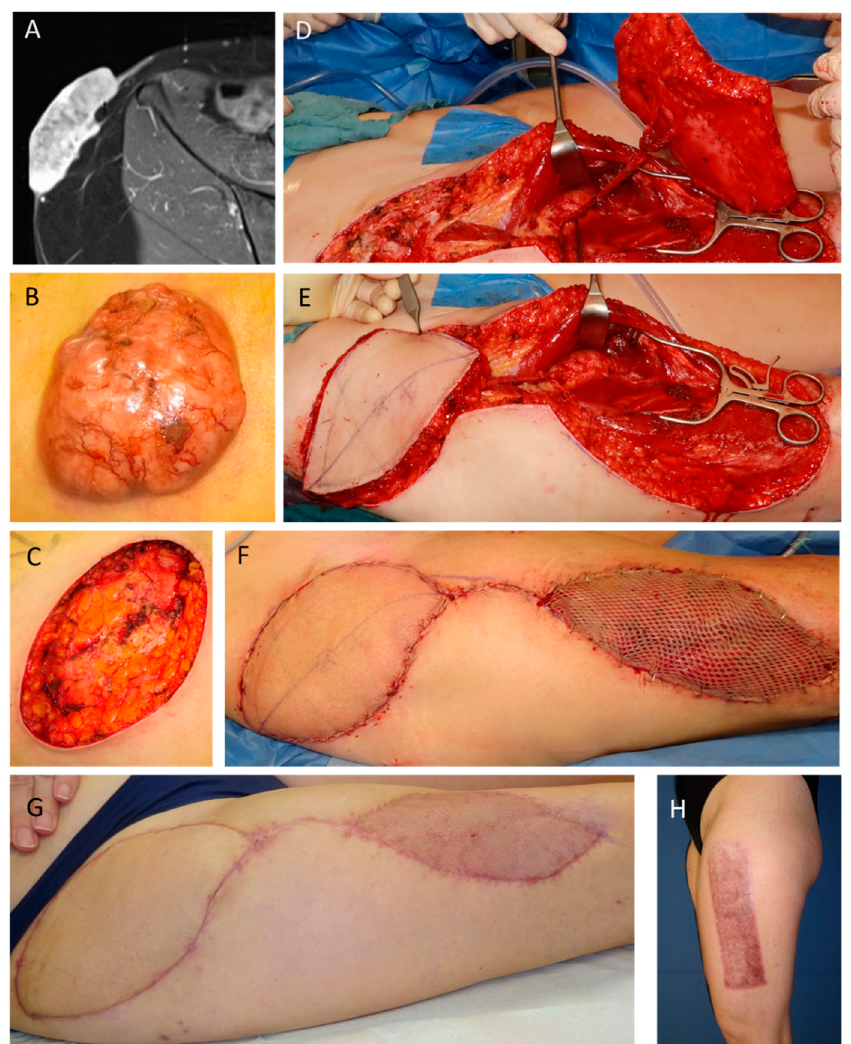
Figure 3. A 47 year-old female patient with a dermatofibrosarcoma protuberans of the right groin ( A : MRI, B : clinical presentation). The tumor resection led to a large soft-tissue defect ( C ), which was covered using a pedicled ALT flap ( D : flap pedicle (descending branch of the lateral circumflex femoral vessels), E : flap insertion, F : final result with split thickness skin graft coverage of the ALT